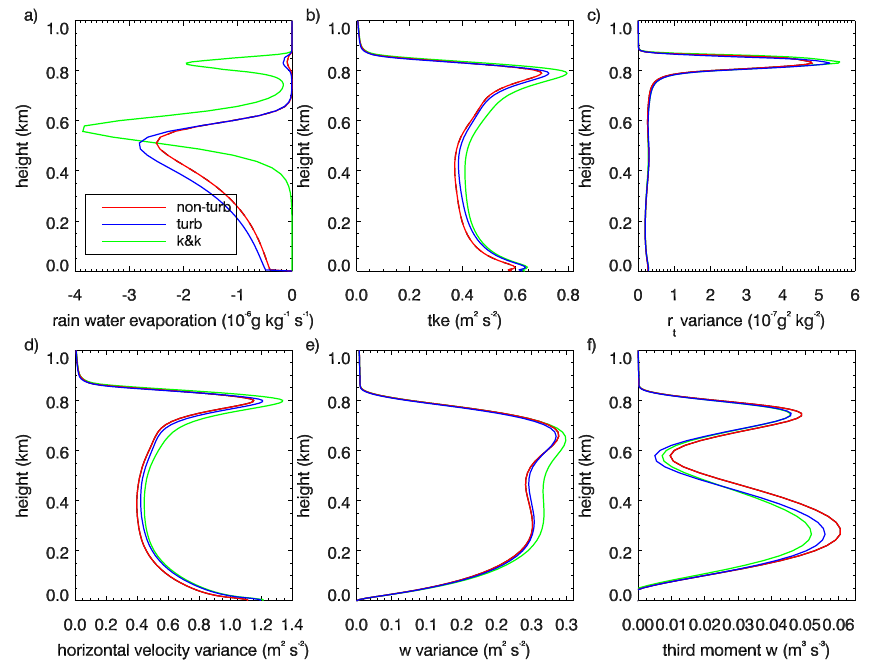
Figure 9. As in Fig. 6 expect for (a) rain water evaporation (gkg − 1 s − 1 ) , (b) turbulent kinetic energy (m 2 s − 2 ) , (c) variance of liquid water (g 2 kg − 2 ) , (d) variance of horizontal velocity (m 2 s − 2 ) , (e) variance of vertical velocity (ms − 1 ) and (f) third moment of vertical velocity (ms − 1 )